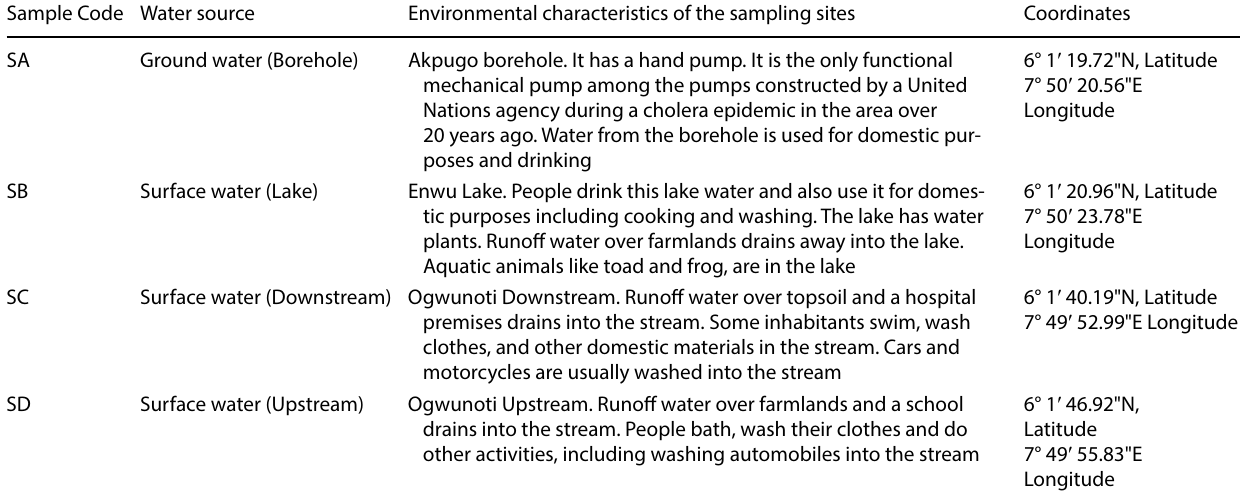
Table 1 The sampling sites and their environmental characteristics Sample Code Water source Environmental characteristics of the sampling